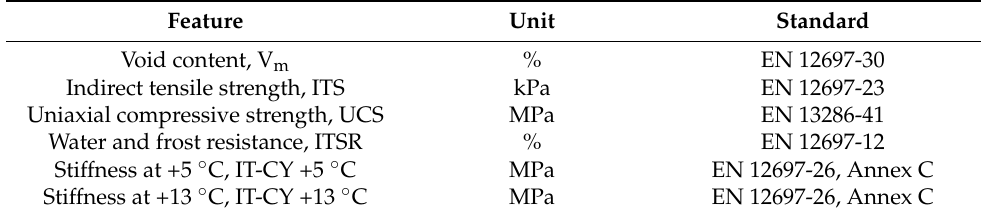
Table 4. Selected physical and mechanical features of the recycled